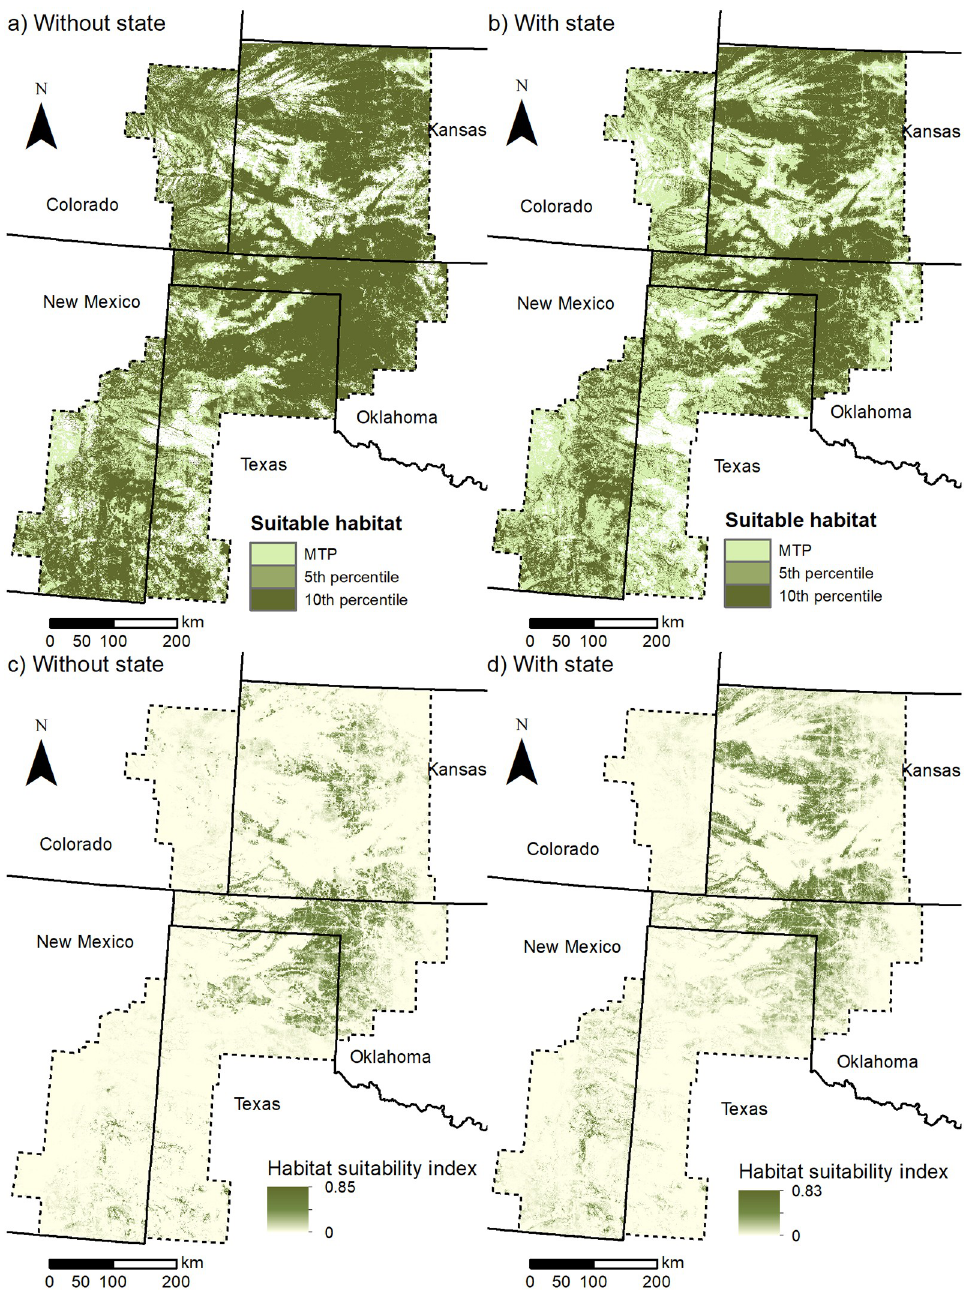
Fig 2. Lek suitability model predictions by threshold and predictor set. Lesser prairie-chicken lek suitability model predictions without state boundary as a predictor (a, c) and including state boundary as a predictor (b, d) displayed as (a- b) the three different suitability thresholds used to classify the models into suitable and unsuitable habitat including minimum training presence (MTP), 5 th percentile, and 10 th percentile and (c-d) the continuous habitat suitability index, displayed using a minimum maximum stretch method. [Projected Coordinate System: Albers Conic Equal